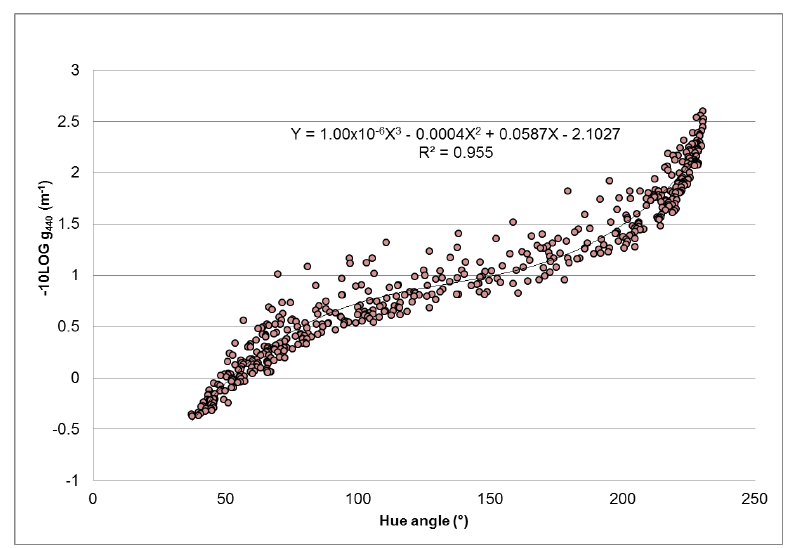
Figure 8. Relation between the hue angle and the absorption (a) of radiation at 440